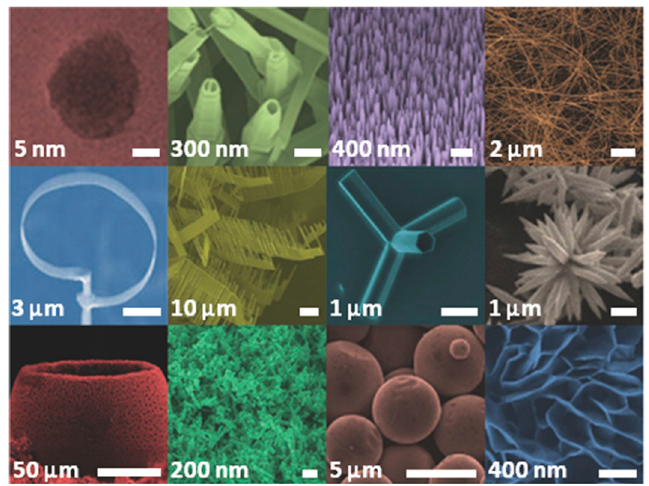
Figure 1. Various and different ZnO nanostructure morphologies. From left to right and from top to bottom: Quantum dot; Nanotubes; Nanowires; Nanobelts; Nanoring; Nanocombs; Tetrapod; Nanoflowers; Hollow spheres; Sponge-like film; Nanosphere; Nanoplates. Adapted with permission from reference [65]. John Wiley & Sons, Inc., 2017.